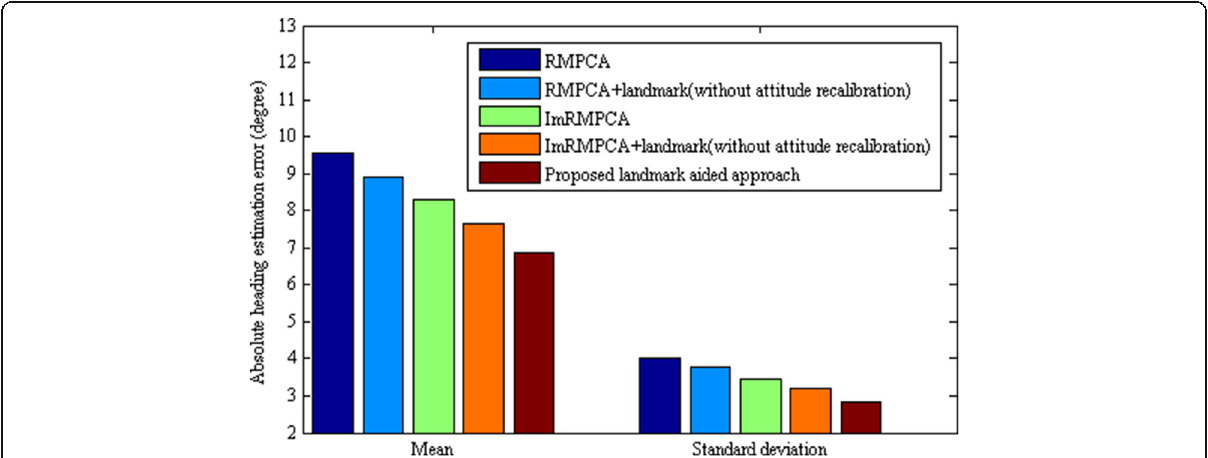
Fig. 5 Performance comparisons of mean and standard deviation of absolute heading estimation